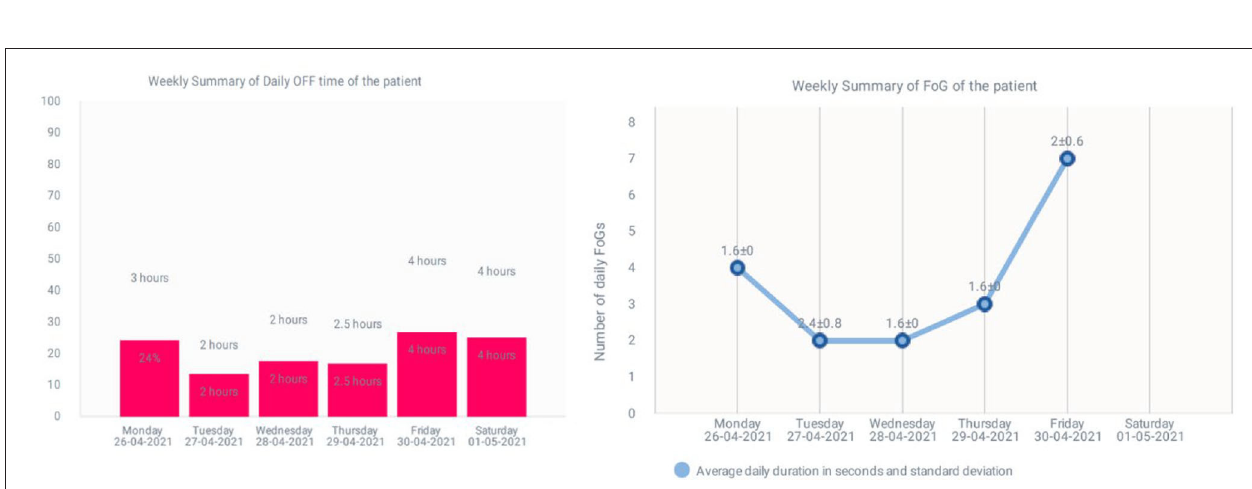
FIGURE 6 | An example of the percentage of OFF hours and total OFF hours and the number of FoG episodes per day.